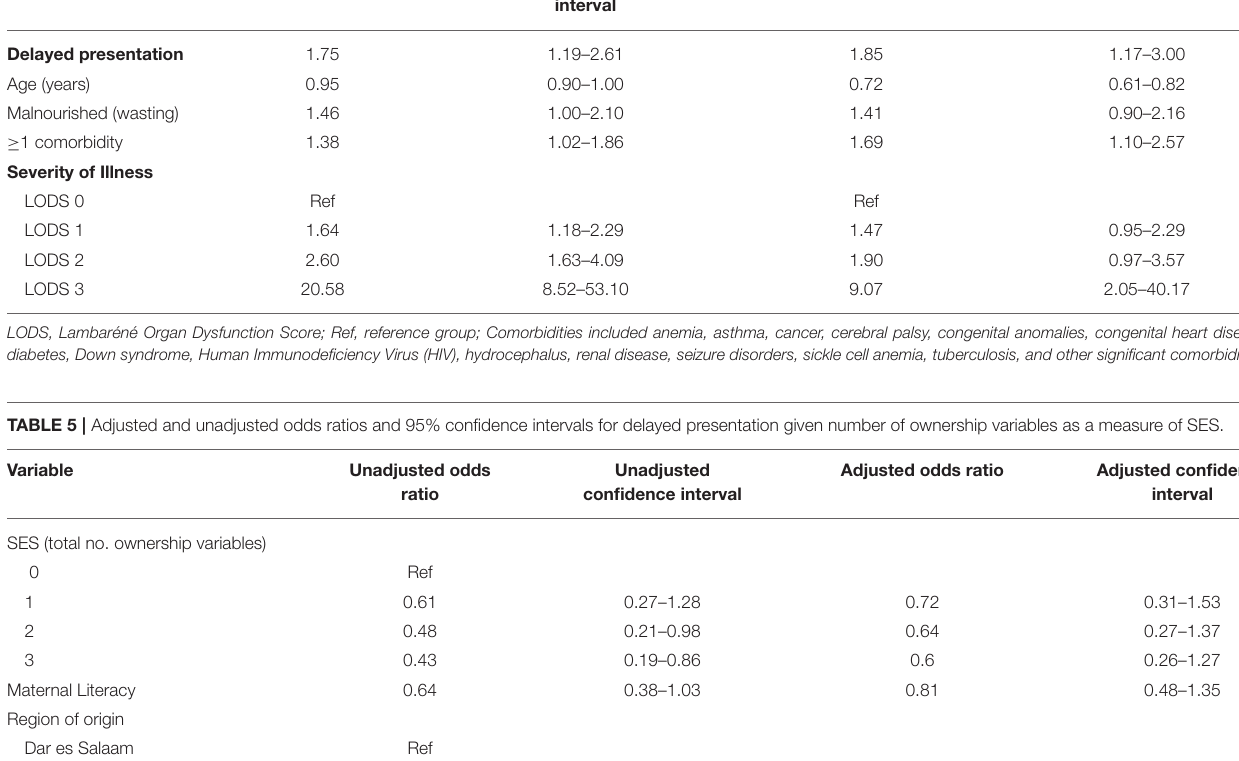
TABLE 4 | Adjusted and unadjusted odds ratios and 95% confidence intervals for mortality and its association with delayed presentation. Variable